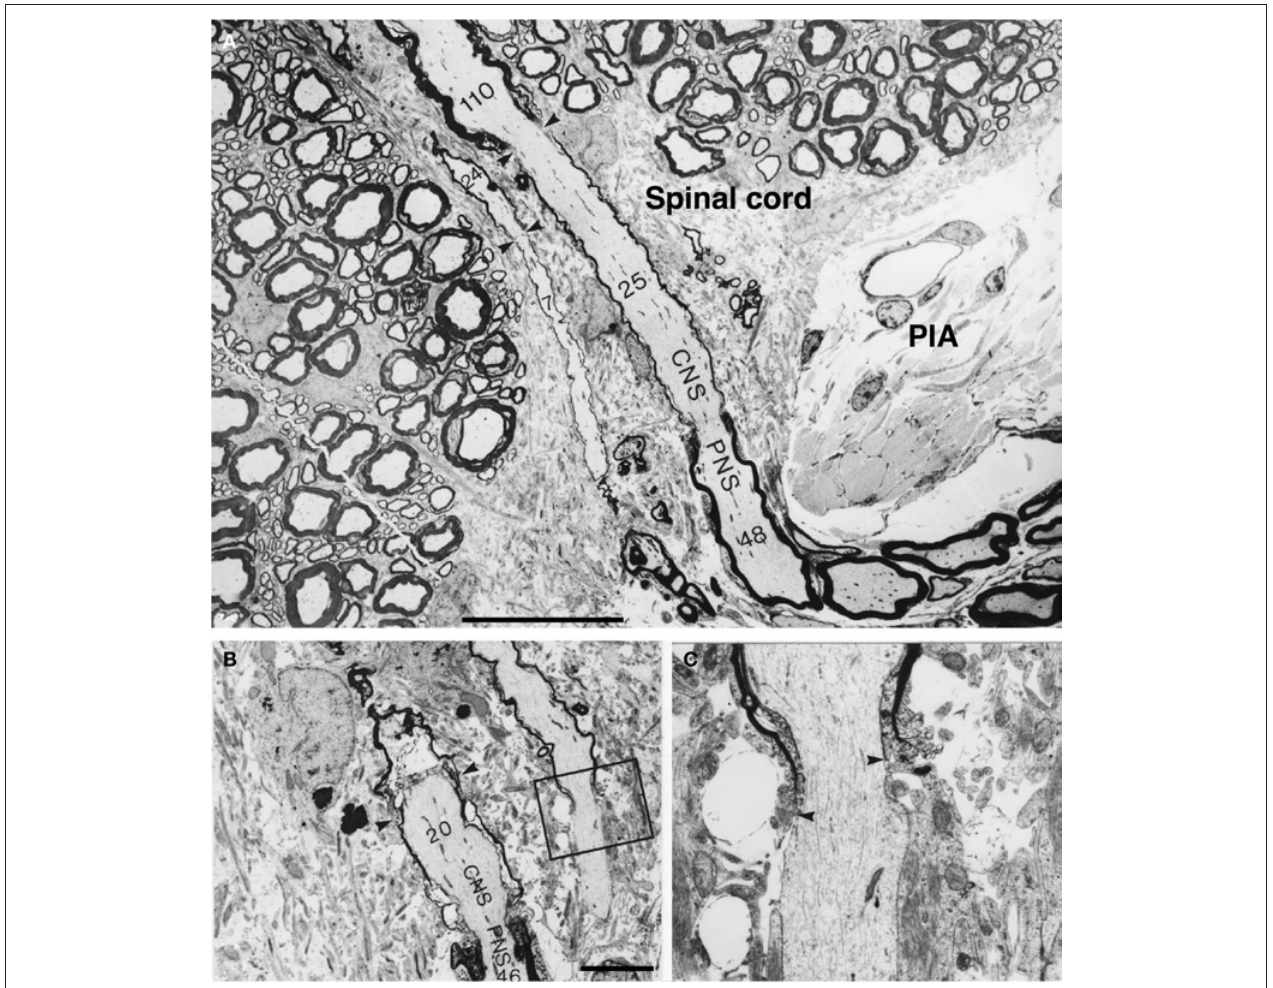
numbers of myelin lamellae (which were counted at high magnification directly in the electron microscope) have been indicated in the axons. The CNS–PNS border node (arrowheads) of one of the axons is included in the micrograph. Note that the number of lamellae in the last CNS-type myelin sheath (20) is less than half of the number observed in the first PNS-type sheath (46). The other axon, which is thinner, presents an unmyelinated segment in the CNS compartment. (C) A high magnification picture showing the “heminode” that is indicated by the box in (B) . A close examination of the site where this myelin sheath terminated (arrowheads) revealed that some of the characteristics of the nodes of Ranvier, like axolemmal undercoating, are lacking. Scale bar = 5